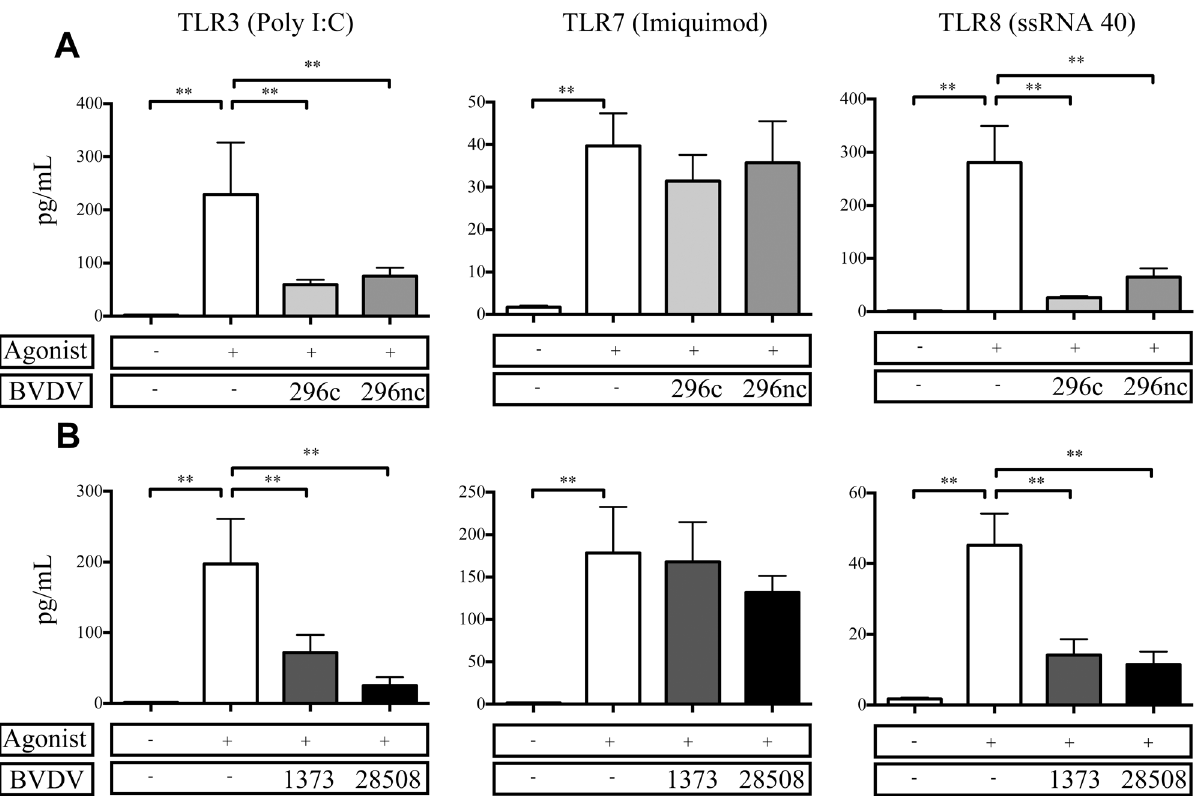
Fig 5. TNF α protein secretion from BVDV2 infected MDM Φ after stimulation with viral TLR agonists. MDM Φ s were differentiated in 96 well plates for 7 days and inoculated with BVDV2 strains with an MOI of 1 for 48 h prior to stimulation with Poly I:C [50 μ g/mL], Imiquimod [10 μ g/mL], ssRNA40 LyoVec [10 μ g/mL]. Cell supernatants were analyzed for TNF α protein concentration 24 h after TLR stimulation and measured by Searchlight Array platform. Incubation with cytopathic and noncytopathic strains are in the top panel (A) or high and low virulence strains indicated in the lower panel (B). Bars represent the mean value ± SEM from four different experiments from 9 total donor cattle. ** P < 0.001 compared to uninfected, TLR stimulated cells.